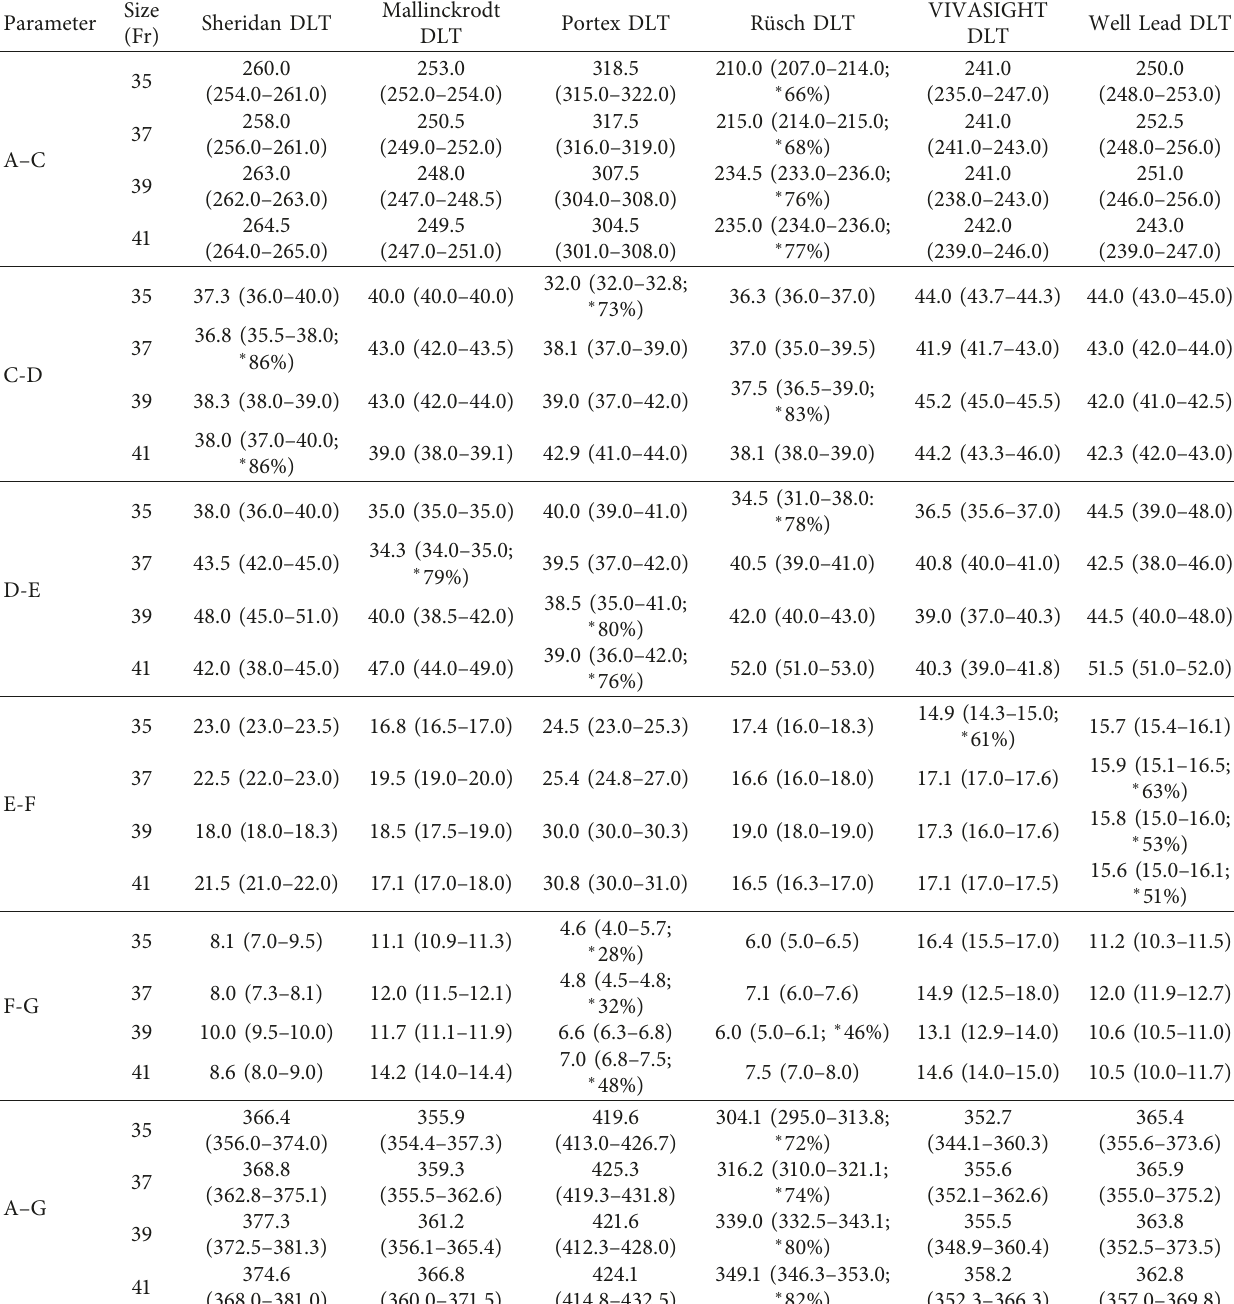
Table 4: Measured length of investigated left-sided double-lumen endobronchial tubes